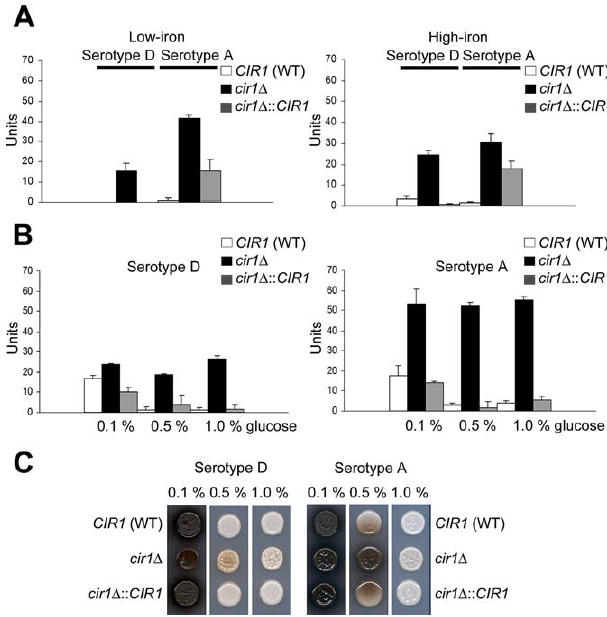
Figure 4. Cir1 Negatively Regulates Laccase Activity (A) Strains were grown in LIM and LIM þ Fe under the same conditions used for the microarray experiments (0.5% glucose), and laccase activity was measured as described in Materials and Methods. WT, wild type. (B) Strains were grown in LIM containing different concentrations of glucose as indicated, and laccase activity was measured. All experiments were repeated three times, and averages are indicated with a bar (standard deviation). (C) Laccase activity of the wild-type, mutant, and reconstituted strains was compared by growing 1.0 3 10 5 cells on DOPA plates with different concentrations of glucose as indicated. Photographs were taken after 3 d of incubation at 30 8 C. DOI: